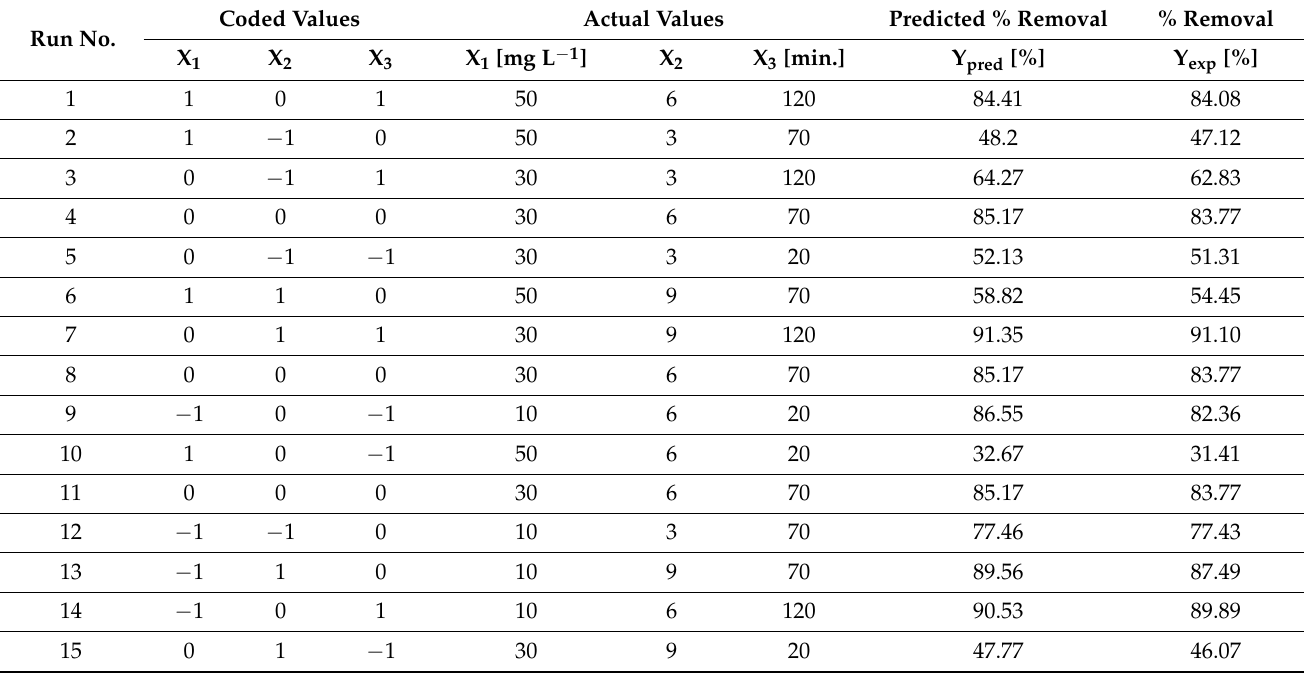
Table 5. Predicted and experimental